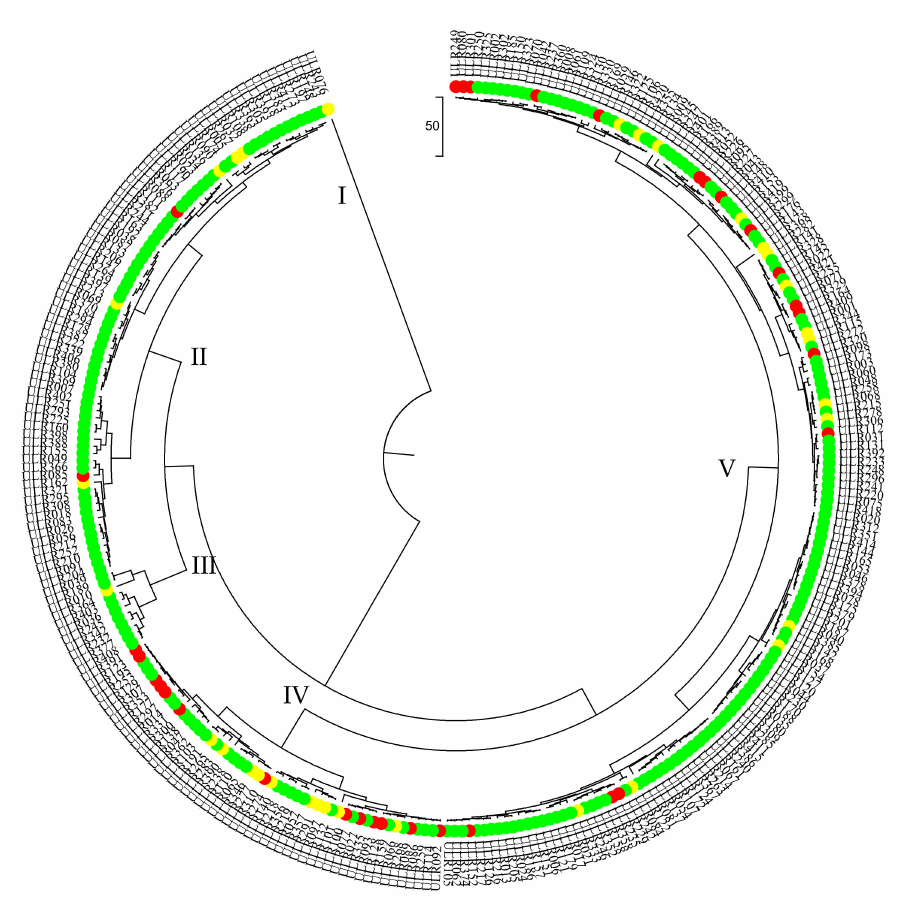
Figure 3. Cluster analysis of 301 indigenous rice germplasm based on days to flowering (DTF), panicle number, tiller number, and grain yield according to Ward’s method. The yellow circle represents the insensitive group (G1), the green circle the weakly sensitive group (G2), and the red circle the strongly sensitive group